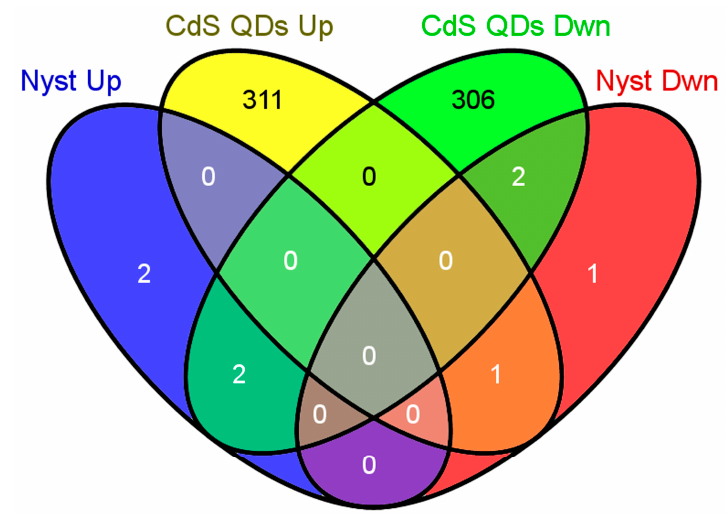
Figure 2. Venn’s diagram representing the overlap between up- and down-regulated genes (fixed thresholds of +1; − 1) with nystatin alone and with nystatin supplemented with CdS QDs. The comparison of the four classes highlights a scant overlap between the two conditions of treatment.